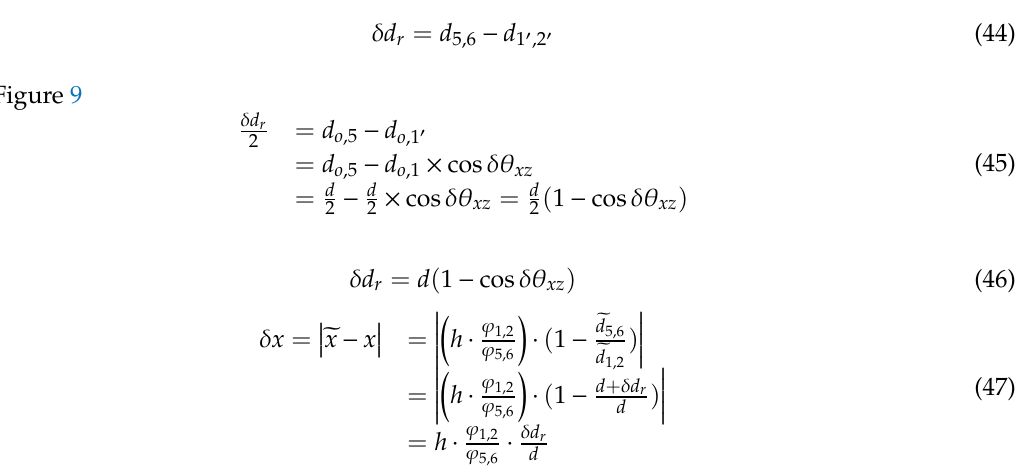
Figure 9. Schematic diagram of the USBL rotation error angle.